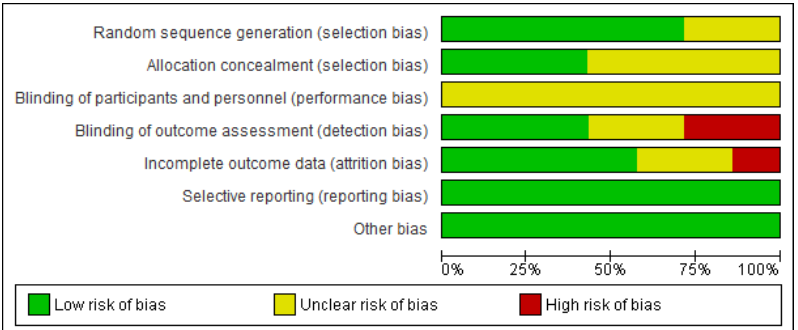
Figure 2. Risk of bias analysis of individual studies.